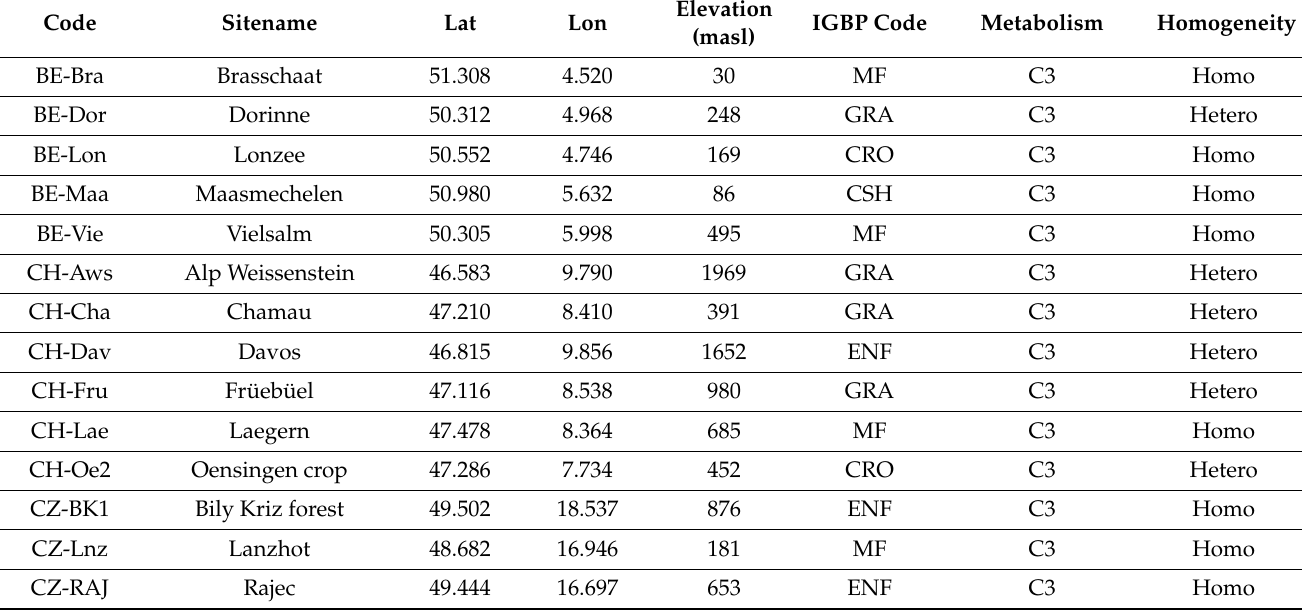
Table A1. Site details: longitude (negative values are west of the prime meridian); latitude (north as positive); site elevation (m above sea level); vegetation categories follow the IGBP land cover classifi- cation: evergreen needleleaf forest (ENF), deciduous broadleaf forest (DBF), mixed forest (MF), closed shrublands (CSH), open shrublands (OSH), savannahs (SAV), grasslands (GRA), permanent wetlands (WET) and croplands (CRO). spatial heterogeneity assessment (homogeneous versus